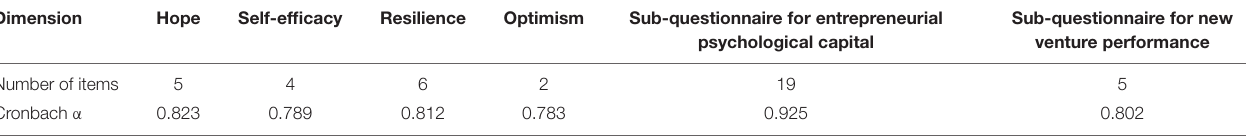
TABLE 4 | Reliability coefficient of the two sub-questionnaires.